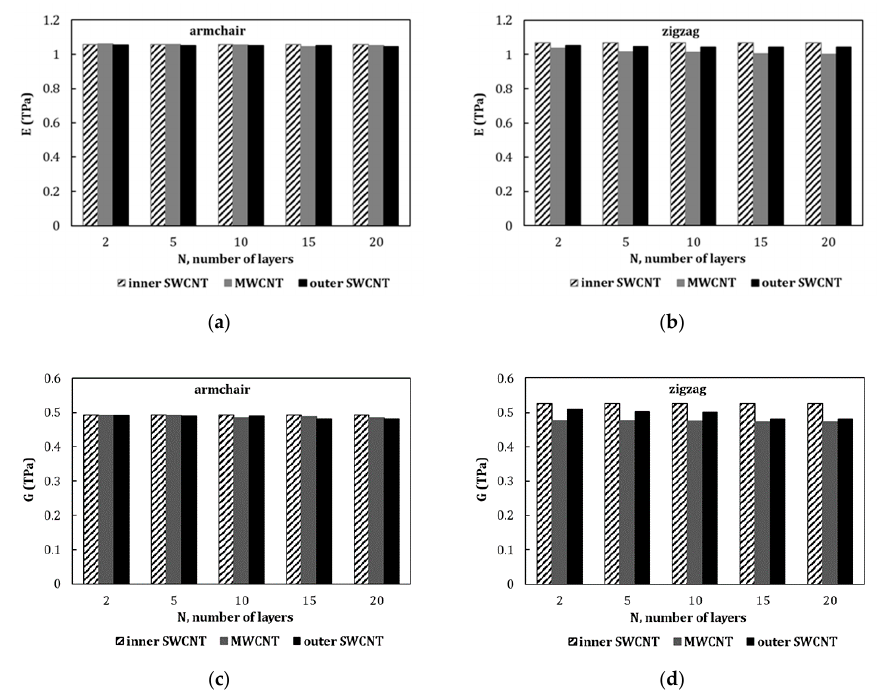
Figure 6. Young’s moduli of MWCNTs compared with the Young’s moduli of the innermost and outermost constituent SWCNTs for nanotubes structures: ( a ) armchair and ( b ) zigzag; shear moduli of MWCNTs compared with the shear moduli of the innermost and outermost constituent SWCNTs for: ( c ) armchair and ( d ) zigzag structures.